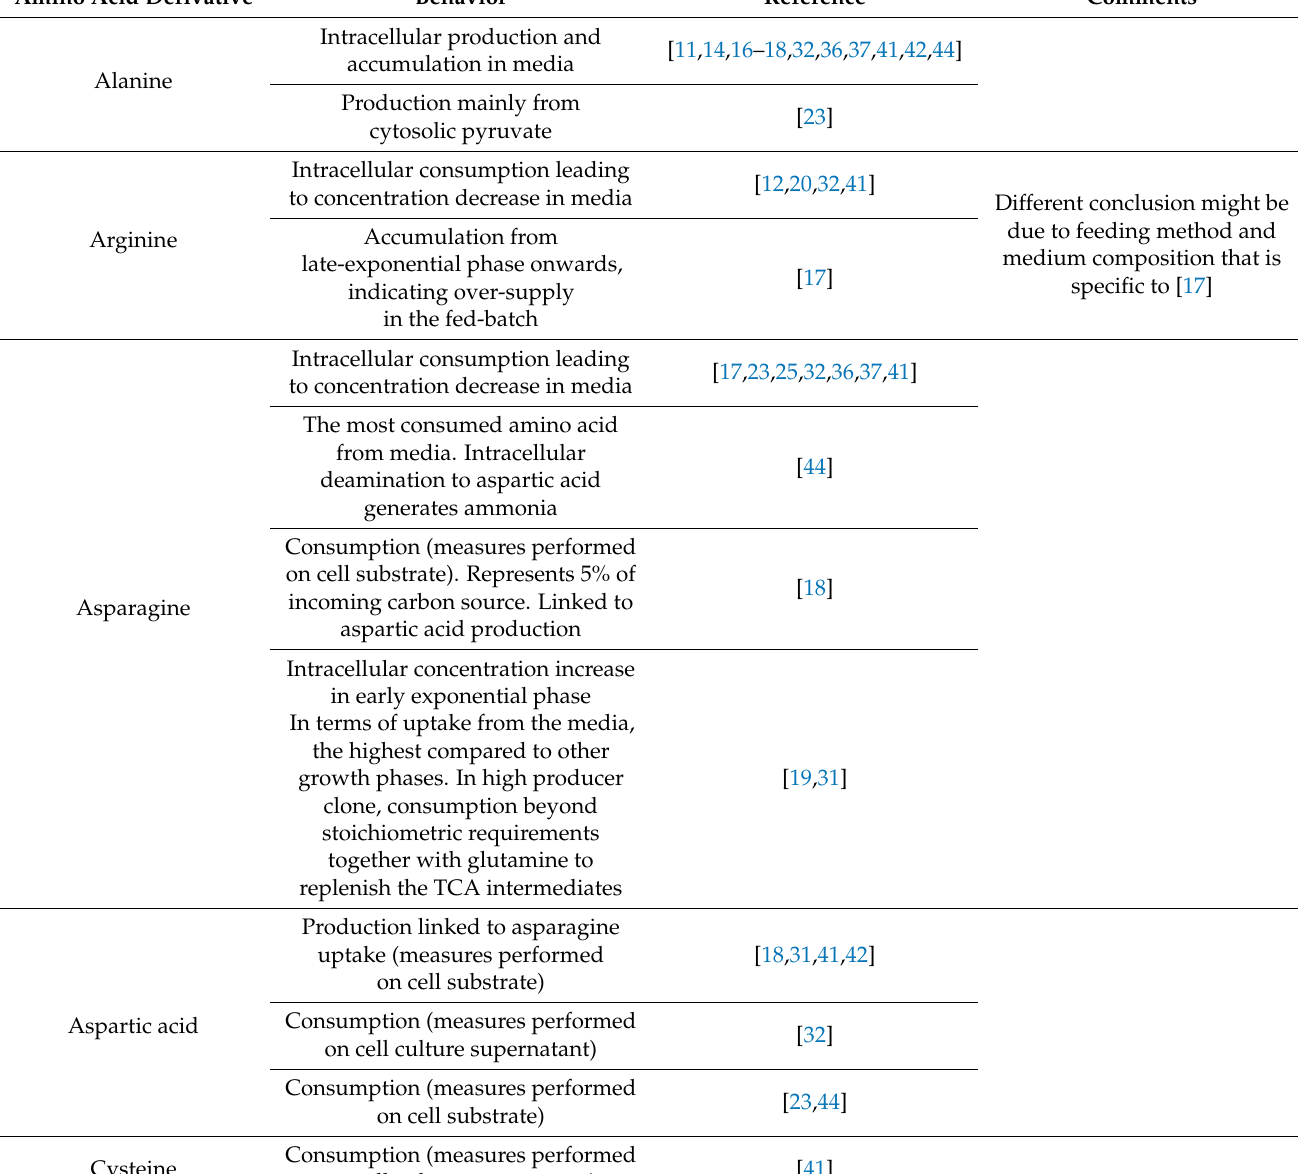
Table 1. Amino acids and amino acid derivatives at the exponential